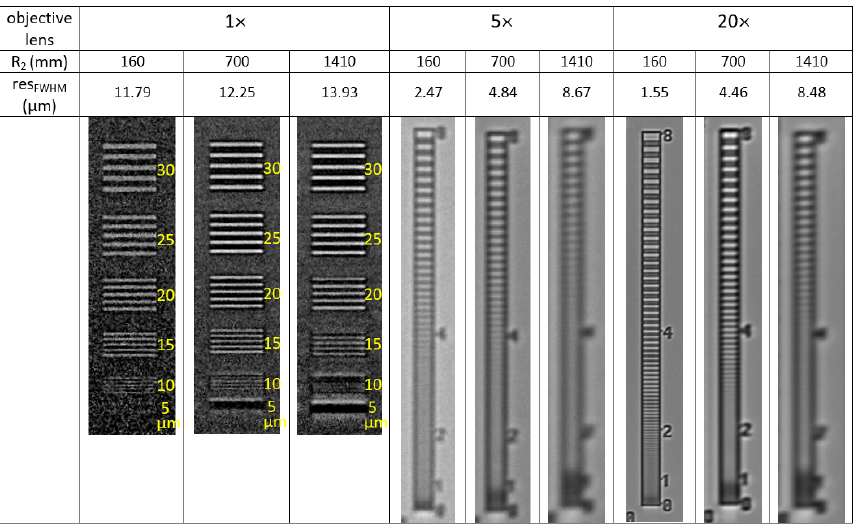
Figure 6. Resolution pattern images in vertical direction taken using 1× objective lens (for QRM MicroCT test pattern) and using 5× and 20× objective lenses (for Xradia X500-200-30 test pattern) at several sample-to-detector distances of 160 mm, 700 mm, and 1410 mm with corresponding theoretical resolution in res FWHM values vertically.